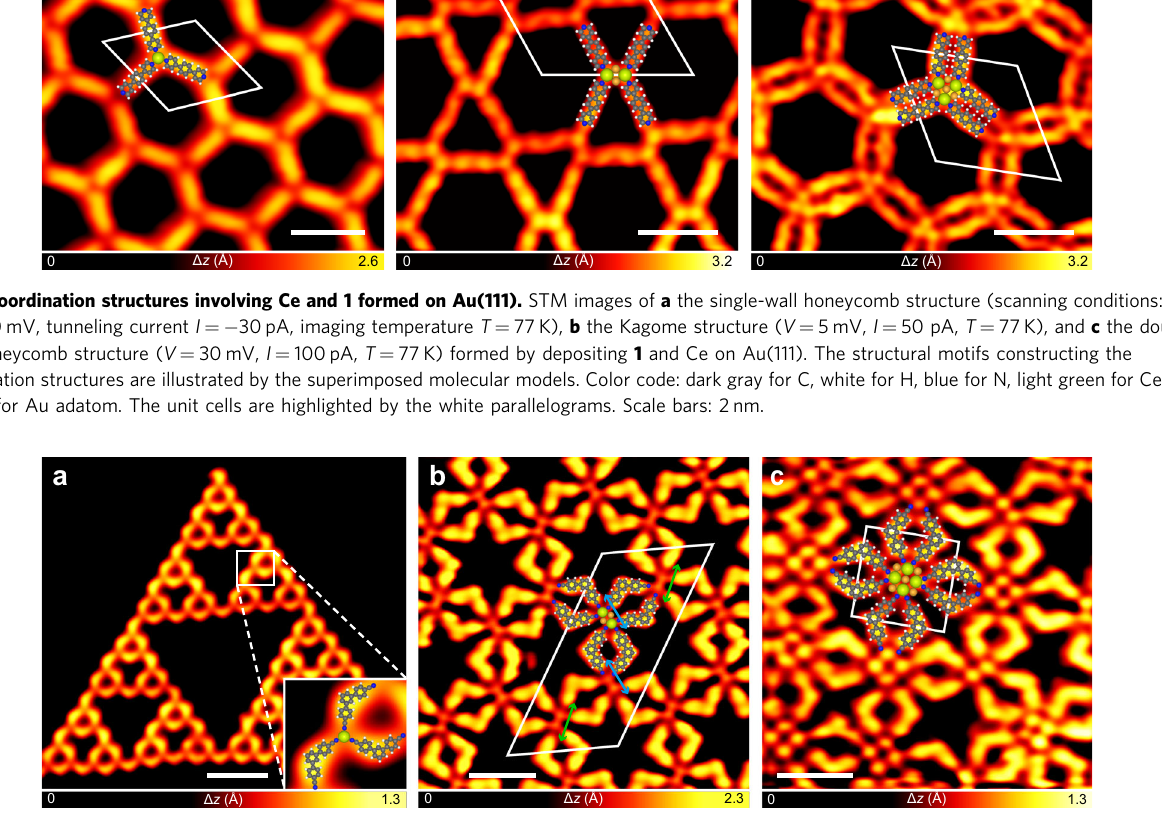
Fig. 3 Coordination structures involving Ce and 2 formed on Au(111). STM images of a a quasi-fourth-order Sierpin ́ ski triangle ( V = 100 mV, I = 20 pA, T = 77 K), b the three-lobe structure ( V = 10 mV, I = 20 pA, T = 4.3 K), and c the four-lobe structure ( V = 10 mV, I = 200 pA, T = 4.3 K) formed by depositing 2 and Ce on Au(111). Inset of a : Magni fi ed image of the Ce(CN) 3 building block of the Sierpin ́ ski triangles. The orientations of the Ce dimers in the three-lobe structure are marked by the green and blue arrows in b . The unit cells are highlighted by the white parallelograms in b and c . The structural motifs constructing the coordination structures are illustrated by the superimposed molecular models. Scale bars: a 5 nm, b 2 nm, and c 2